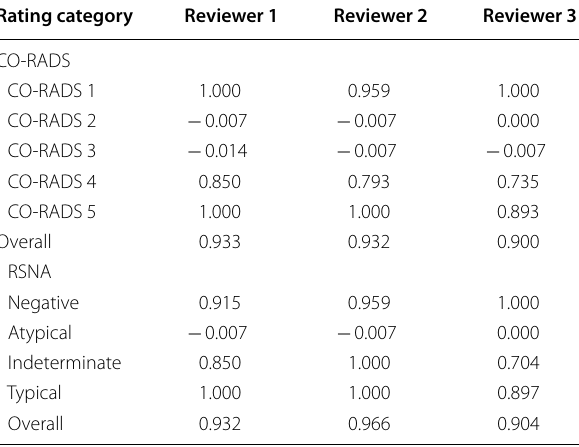
Table 7 Intra‑reviewer agreement for CO‑RADS and the RSNA chest CT classification system stratified according to different categories and